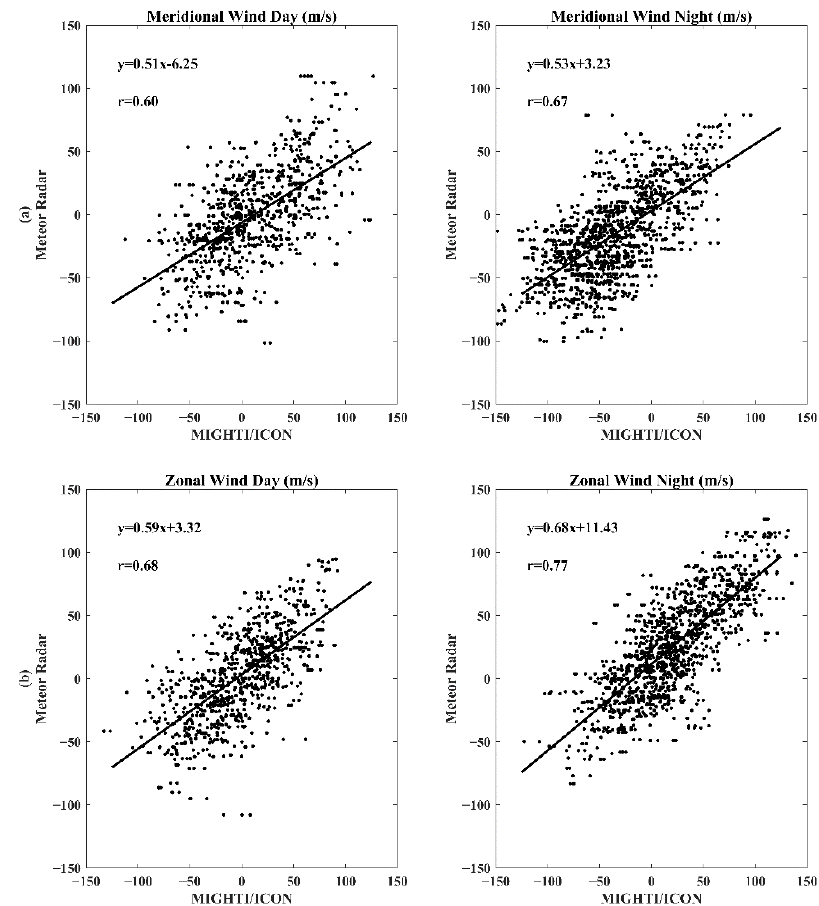
Figure 6. Scatter diagram of horizontal wind measurements from MIGHTI/ICON and meteor radar. The left side is daytime measurement, and the right side is night measurement. ( a ) Meridional wind; ( b ) zonal wind.